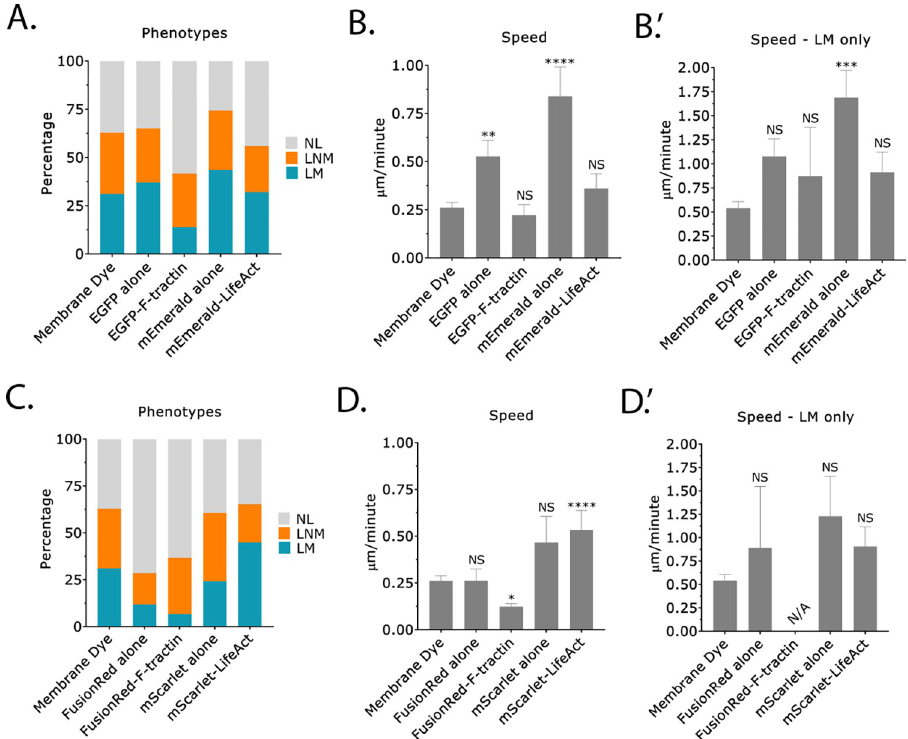
Fig 6. LBBM is affected by fluorescent protein markers. A. Percent of no leader (NL), leader non-mobile (LNM), and leader mobile (LM) for melanoma A375-M2 cells stained with membrane dye (n = 124 cells), transiently transfected with EGFP alone (n = 92 cells), EGFP-F-tractin (n = 43 cells), mEmerald alone (n = 37 cells), or mEmerald- LifeAct (n = 47 cells). B. Instantaneous speeds for all cells transfected as in ( A ). B’. Instantaneous speeds for leader mobile (LM) cells transfected as in ( A ). C. Percent of no leader (NL), leader non-mobile (LNM), and leader mobile (LM) for melanoma A375-M2 cells stained with membrane dye (n = 124 cells), transiently transfected with FusionRed alone (n = 45 cells), FusionRed-F-tractin (n = 29 cells), mScarlet alone (n = 33 cells), or mScarlet-LifeAct (n = 47 cells). D. Instantaneous speeds for all cells transfected as in ( C ). D’. Instantaneous speeds for leader mobile (LM) cells transfected as in ( C ). Error is SEM. Statistical significance was determined using a One-way ANOVA and a Kruskal- Wallis post hoc test. All data are representative of at least three independent experiments. � —p � 0.05, �� —p � 0.01, ��� —p � 0.001, and ���� —p �